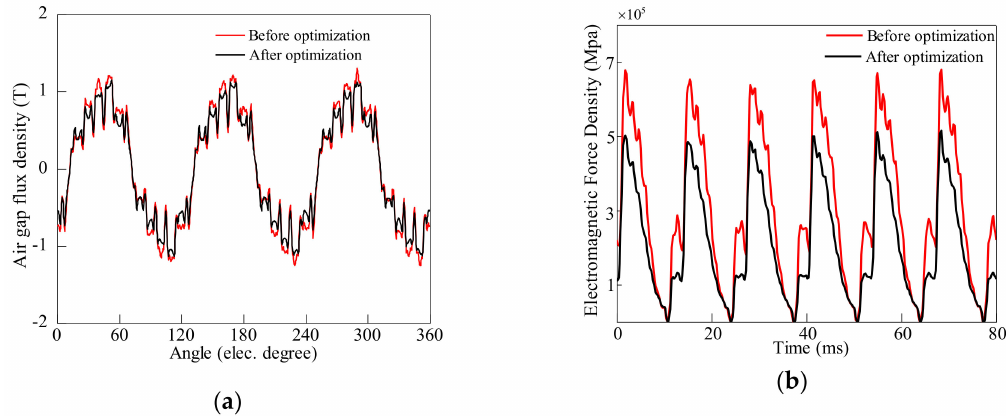
Figure 16. Comparison of radial air-gap flux density and time-varying electromagnetic force at position 3 before and after optimization. ( a ) Radial air-gap flux density; ( b ) Radial time-varying electromagnetic force.